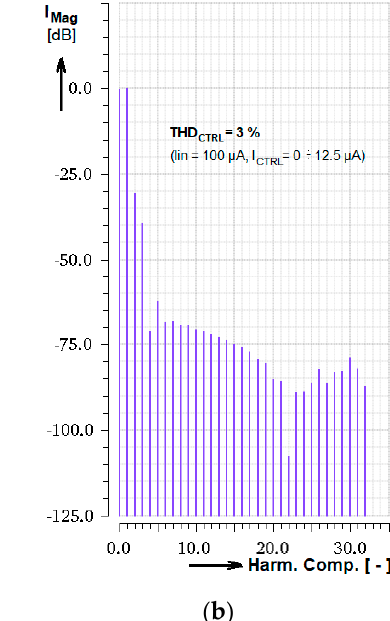
Figure 13. Frequency transfer characteristics with measured bandwidth in the scope (0.46 ÷ 1.0) MHz. Table 3. Amplifier properties summary. Parameter Simulated (Nominal) Measured (Selected Prototype) small-signal gain and AC transfer bandwidth ( − 3 dB) B(i) for I CTRL = 1 µA